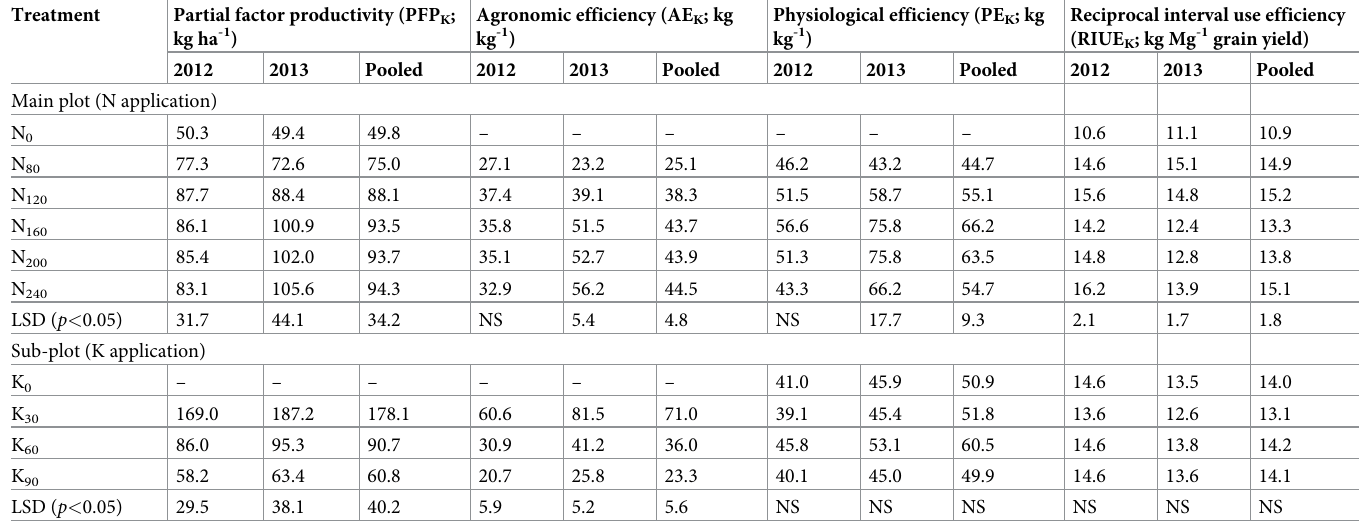
Table 6. Effect of nitrogen (N) and potassium (K) application on K use efficiency in wheat ( Triticum aestivum L.) in a sandy loam soil in sub-tropical India. Treatment Partial factor productivity (PFP K ; kg ha -1